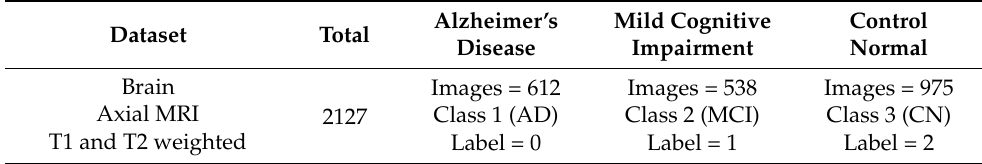
Figure 2. Framework for Alzheimer’s disease classification and prediction using various algorithms. Table 2. Detailed Sample-wise Distribution of